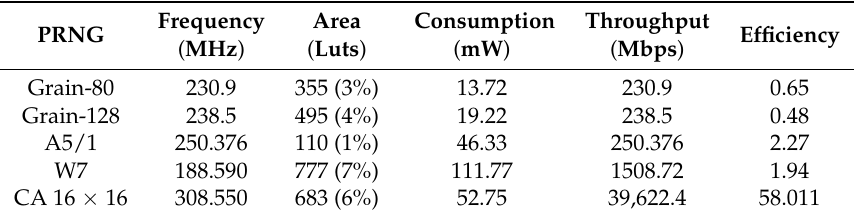
Table 6. Synthesis results of the different Pseudorandom Number Generator